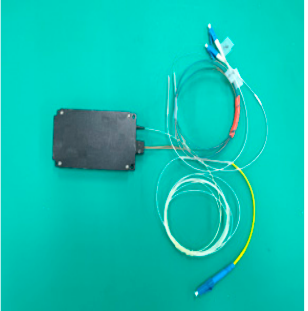
Figure 4. 17-channel AAWG module.